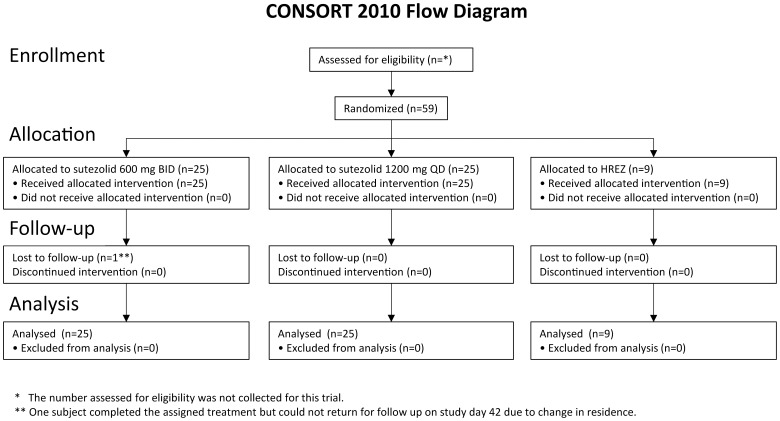
CONSORT flow diagram of study enrollment.